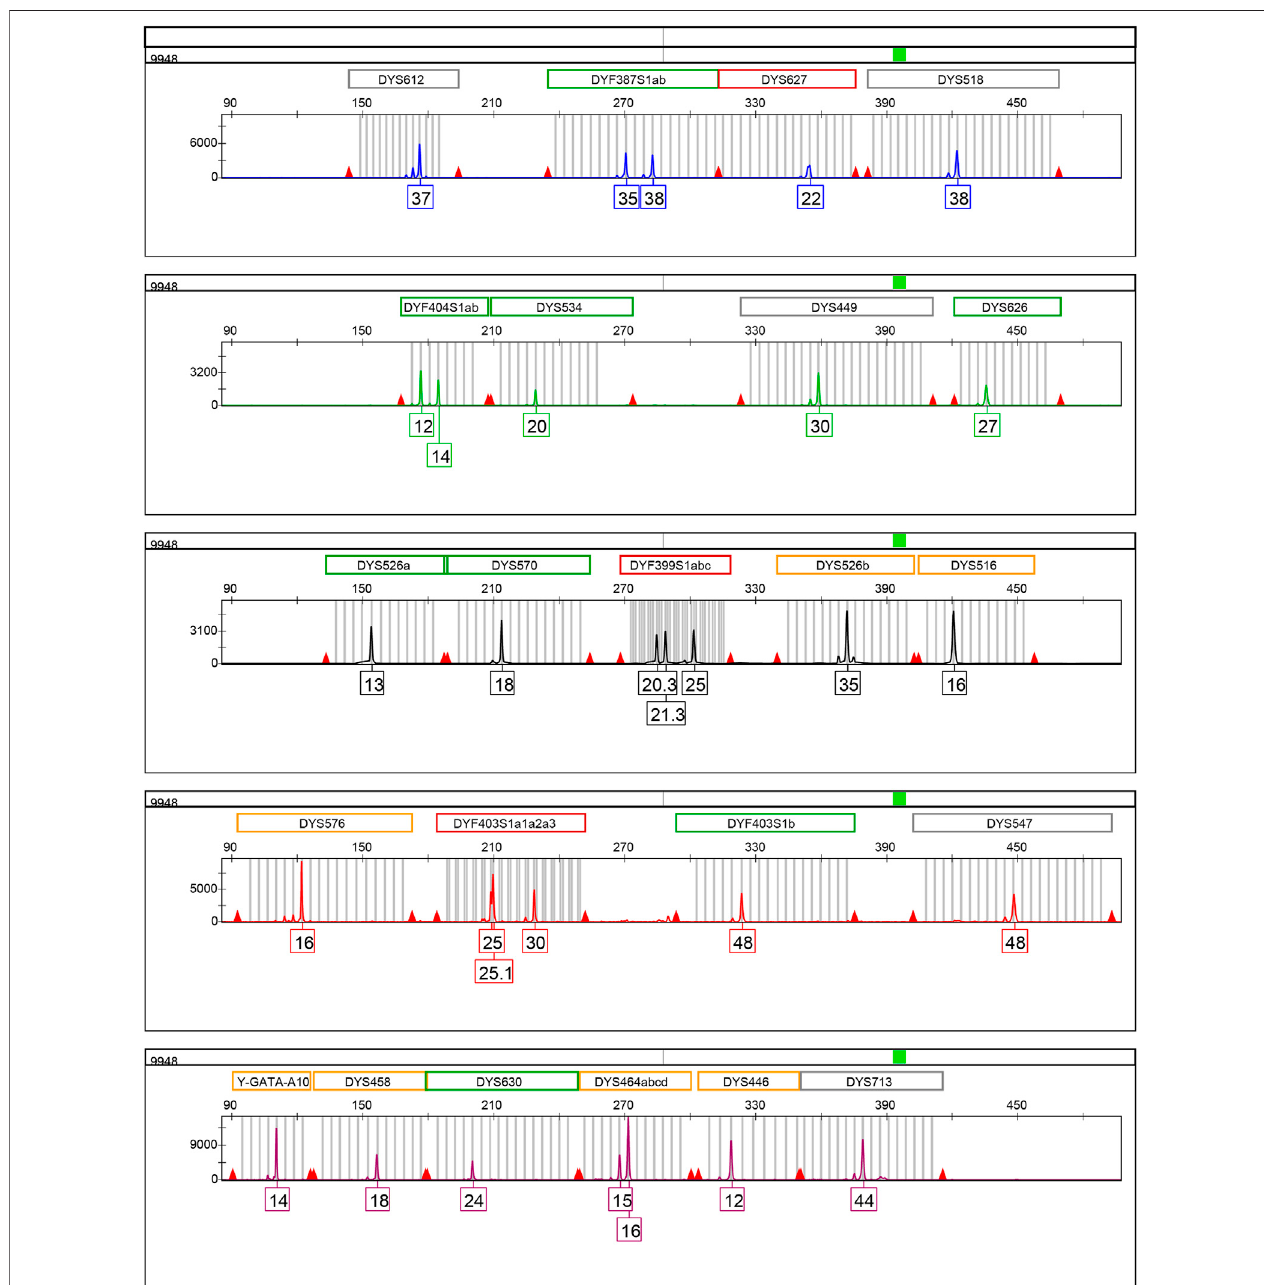
FIGURE1| Allelic pro fi leof32RM Y-STRsofthepositivecontrolDNAsample9948(1 ng/ μ l)ampli fi edbytheHomyGeneRMY32panel. Differentcolorsrepresent different dyes: blue for FAM, green for HEX, black for TAMRA, red for ROX, and purple for